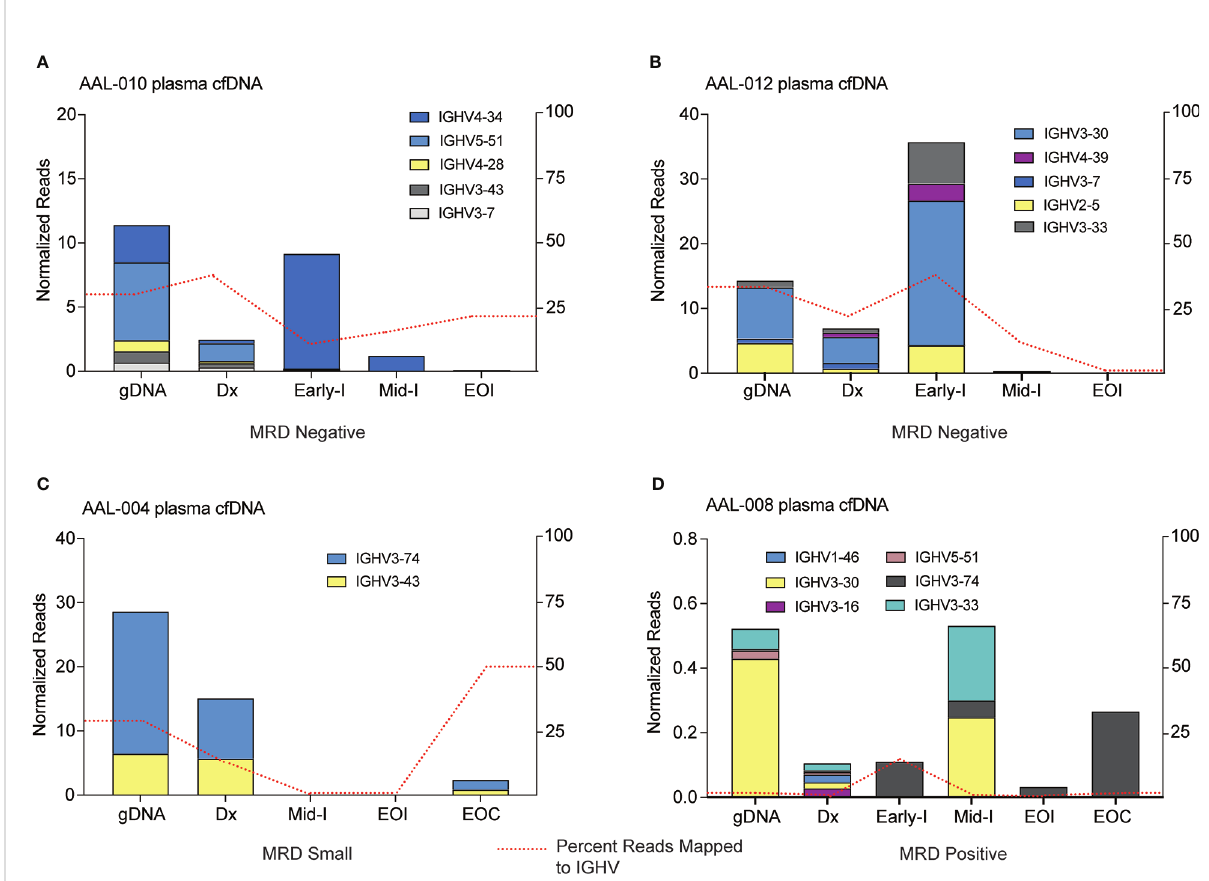
FIGURE 4 IGHV sequencing of cfDNA can de fi ne B-ALL heterogeneity and track clonal response throughout treatment. cfDNA was extracted from plasma samples of four patients, IGHV regions were PCR ampli fi ed, and resultant libraries were sequenced using MinION. Data were analyzed using Galaxy. Clones present in the genomic DNA (gDNA) and cell-free DNA plasma samples at diagnosis (Dx) that comprised at least 5% of total reads were tracked across treatment timepoints. Clone abundance is normalized to total mapped reads per library and shown on the left axis. The percentage of reads aligned to the IGHV region on Chr14 (red dashed line) is a relative indicator of leukocyte abundance at each timepoint/ sample and is shown on the right axis. Patients in (A, B) were clinically diagnosed as MRD negative via fl ow cytometry. Patient (C) was MRD negative but had blasts present in the sample that did not reach the clinical cut-off of one blast per 10,000 cell thresholds for MRD diagnosis. Patient (D) was diagnosed as MRD